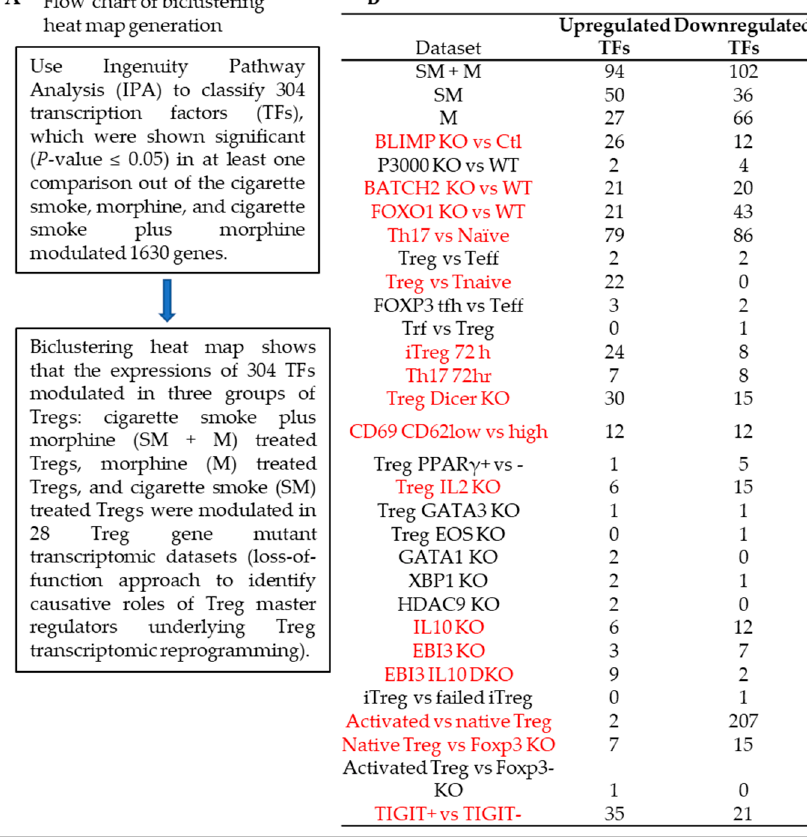
Figure 8. ( A ) Flow chart of biclustering heat map generation. ( B ) The expressions of cigarette smoke plus morphine (SM + M) modulated 304 transcription factor (TF) genes in Tregs were regulated in 28 transcriptomic datasets (cutoff: l FC l > 1). Of note, the 16 datasets with significant modulation of the expressions of more than 10 TFs were highlighted in red including BLIMP-KO, BATCH-KO, FOXO1-KO, Th17, Treg, iTreg 72 h, Th17 72 h, Treg Dicer, CD69-CD62 Low , Treg IL2-KO, IL10-KO, EBI3-KO, EBI3-IL-10-DKO, activated Treg, native Treg, and TIGIT + vs. TIGIT — . ( C ) Biclustering heat